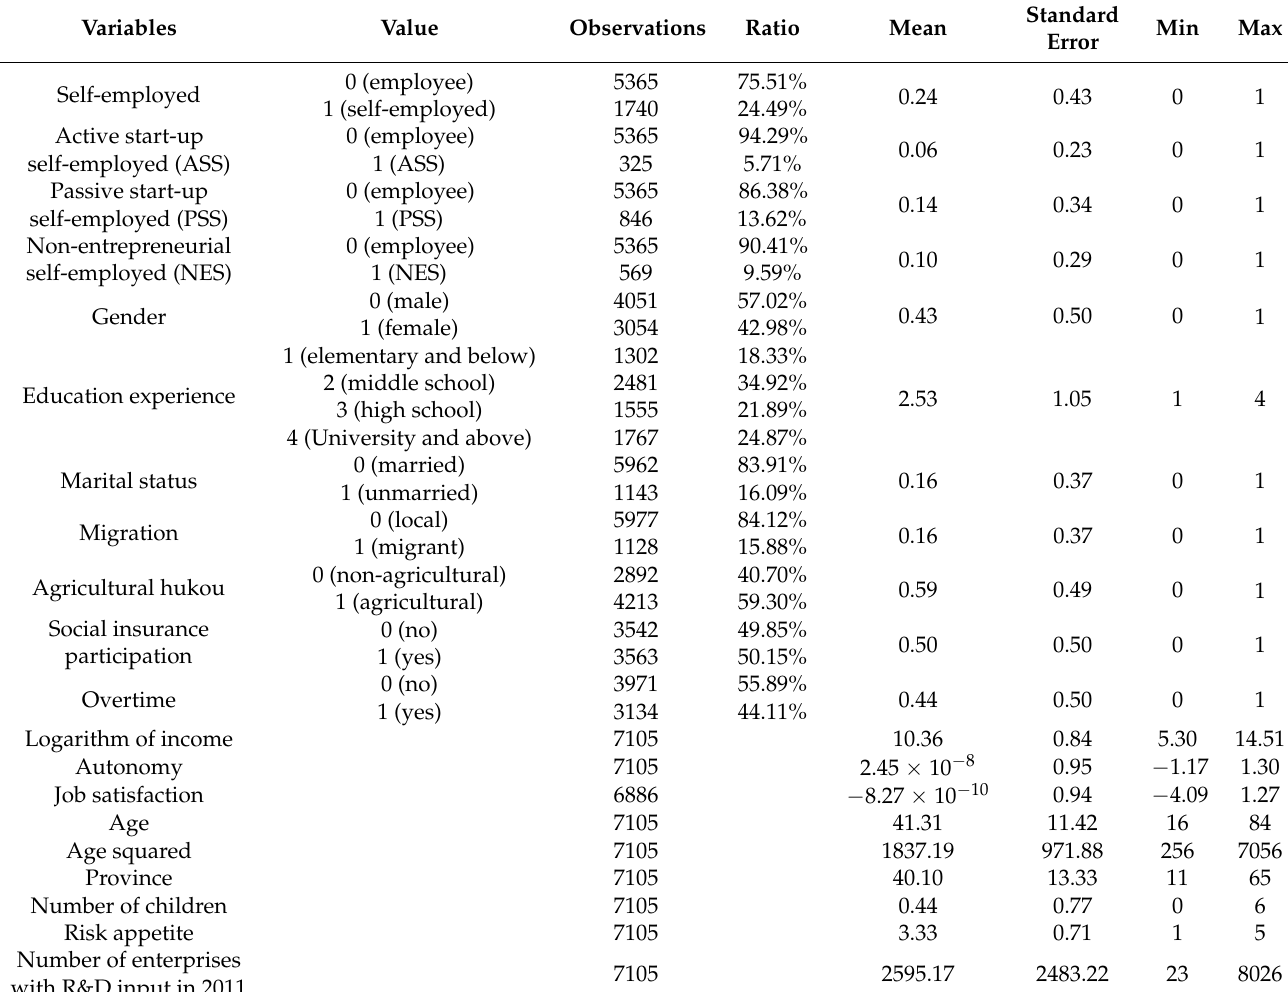
Table 2. Descriptive statistics of core variables (Unit: